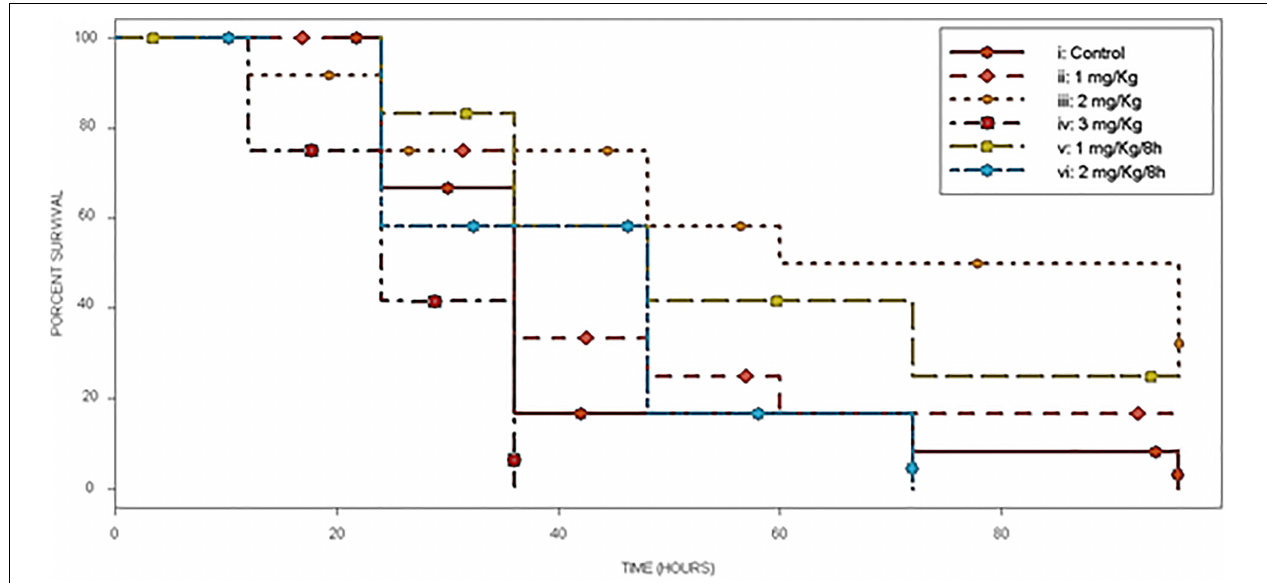
FIGURE 7 | Survival curve of the experimental murine model of MDR infection. Control (i) and 5 different treatments (ii–vi) with Fluopsin C, in septicemia protection model using CRE–Kpn19. Survival is depicted until 96 h after infection.